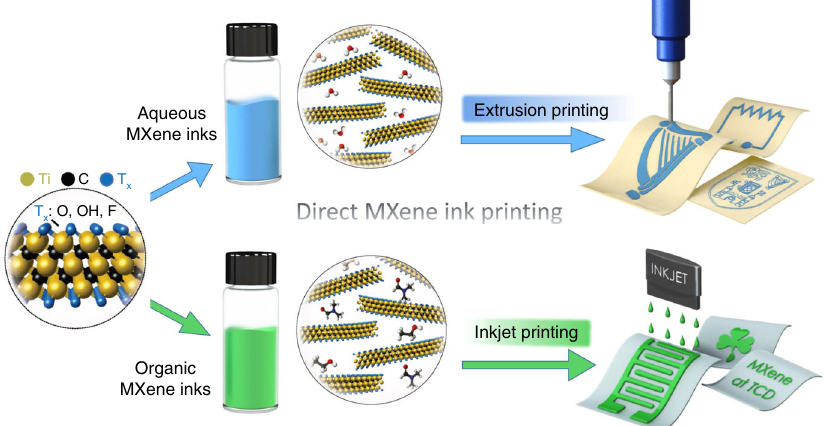
Fig. 1 Schematic illustration of direct MXene ink printing. The Ti 3 C 2 T x organic inks, i.e., Ti 3 C 2 T x -ethanol (molecules shown in the bottom panel) are used for inkjet printing of various patterns, such as MSCs, MXene letters, ohmic resistors, etc. The Ti 3 C 2 T x aqueous inks (with water molecules shown in the top panel) are designed for extrusion printing of MSCs and other patterns on fl exible substrates. As for the MSCs, a gel electrolyte made of H 2 SO 4 -PVA, was coated onto the as-printed patterns and dried naturally, forming all-MXene printed,